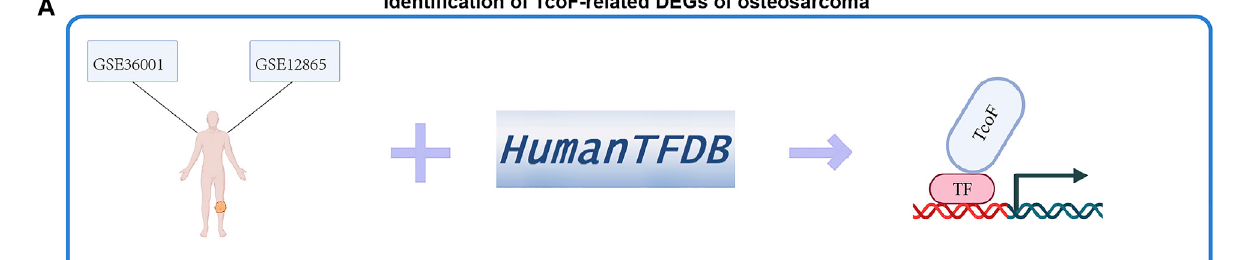
FIGURE1 | Flow chart ofthe study. (A) 83 TcoF-related DEGs ofosteosarcoma were identi fi ed through two GEO databases (GSE36001 and GSE12865) and the Human Transcription Factordatabase. (B) Prognosticriskscoremodel with fi ve TcoF-related geneswasconstructed based ontheTARGETdatabase. (C) Validationof the risk model in the database. (D) Expressions of TcoF-related genes were validated by qRT-PCR and IHC. TcoF, transcription co-factor; DEG, differentially expressed gene; GEO, Gene Expression Omnibus; TARGET, Therapeutically Applicable Research to Generate Effective Treatments database; qRT-PCR, quantitative real- time PCR; TMA, tissue microarray; IHC, immunohistochemistry.